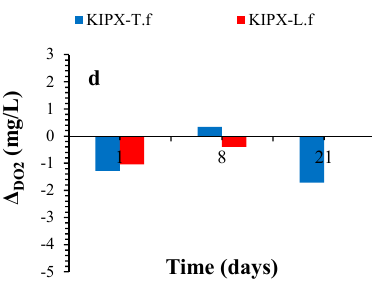
Figure 3 . Effects of various flotation reagents on dissolved oxygen during L. ferrooxidans and T. ferrooxidans activities.